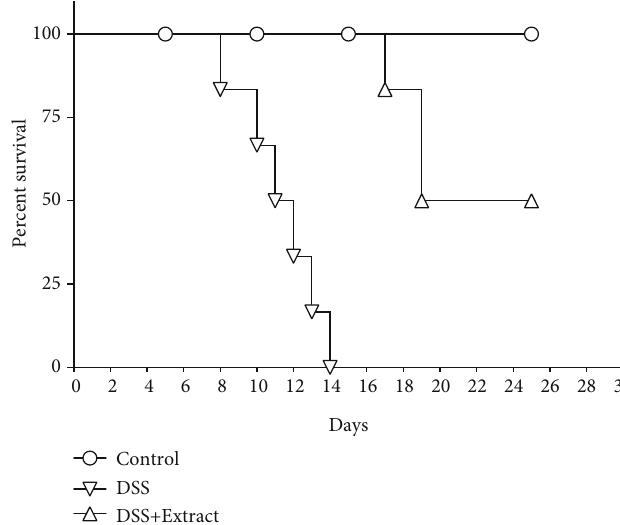
Figure 1: E ff ects of the methanolic extract of C. procera on the % survival during DSS-induced colitis. Experimental groups were formed with an n = 6 ; treatment with the extract was at a doss of 200 mg/kg. It was determined as a human endpoint when each mouse reached the maximum values according to the DAI, that is, the maximum value of weight loss, diarrhea, and bleeding. The experiment was performed in triplicate showing that there is a signi fi cant di ff erence between the curves. P < 0 : 0001 versus DSS (Mantel-Cox